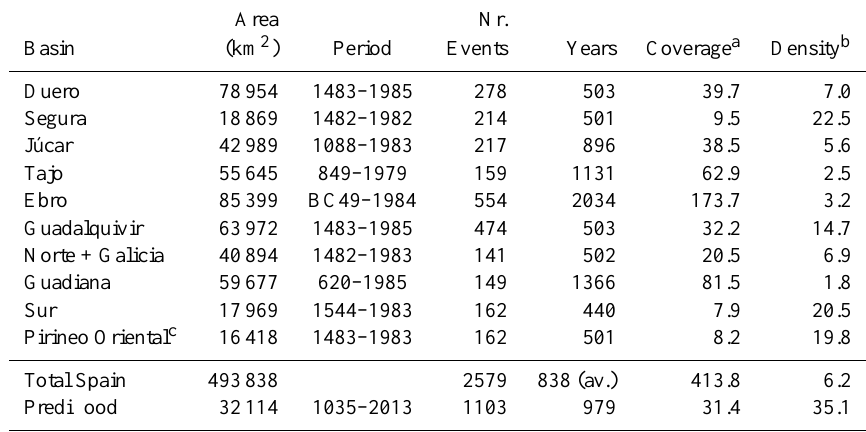
Table 4. Comparative values between the flood compilations of Civil Protection Spain and the Prediflood project. Source: “Catálogo Nacional de Inundaciones Históricas” (2006–2010), Ministerio del Interior, España.